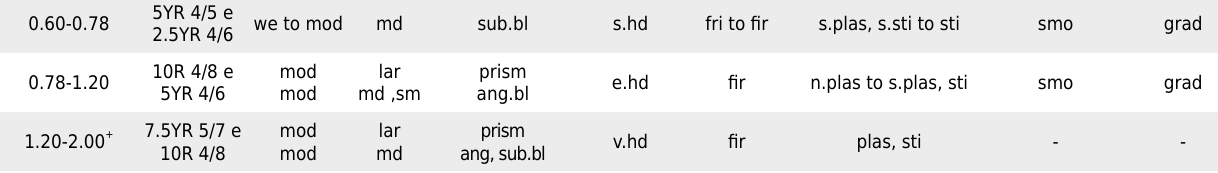
Table 1. Morphological characterization of the soil in horizons A and B of the studied profiles 2Btf 1